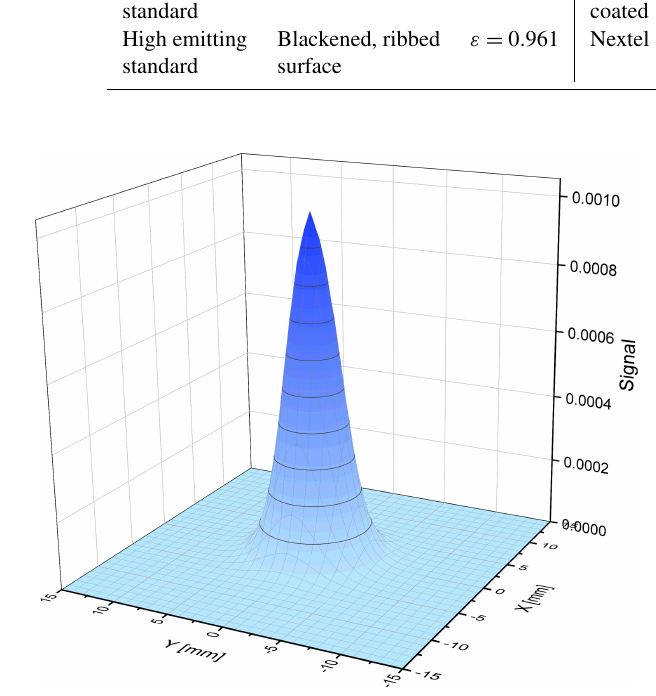
Figure 8. The measurement field of the TIR 100-2 shown as a 3-D plot resulting from the varied aperture method.